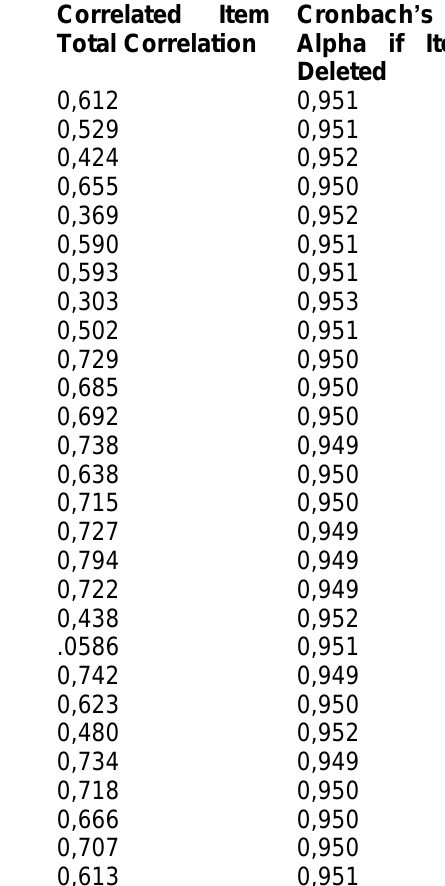
Table 2: Item statistics for operations skills